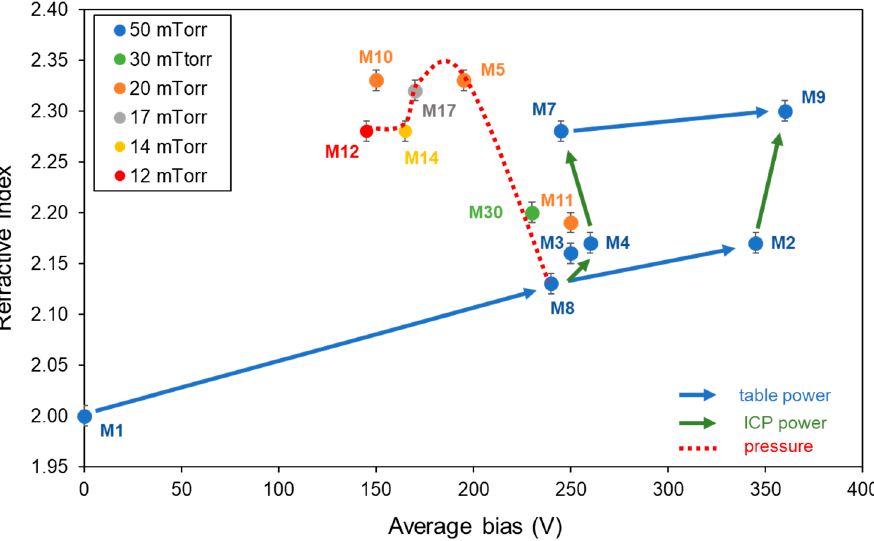
Figure 2. Evolution of the refractive index with the average bias during deposition for all tested conditions and illustration of the influence of an increase in each of the three parameters on the index.